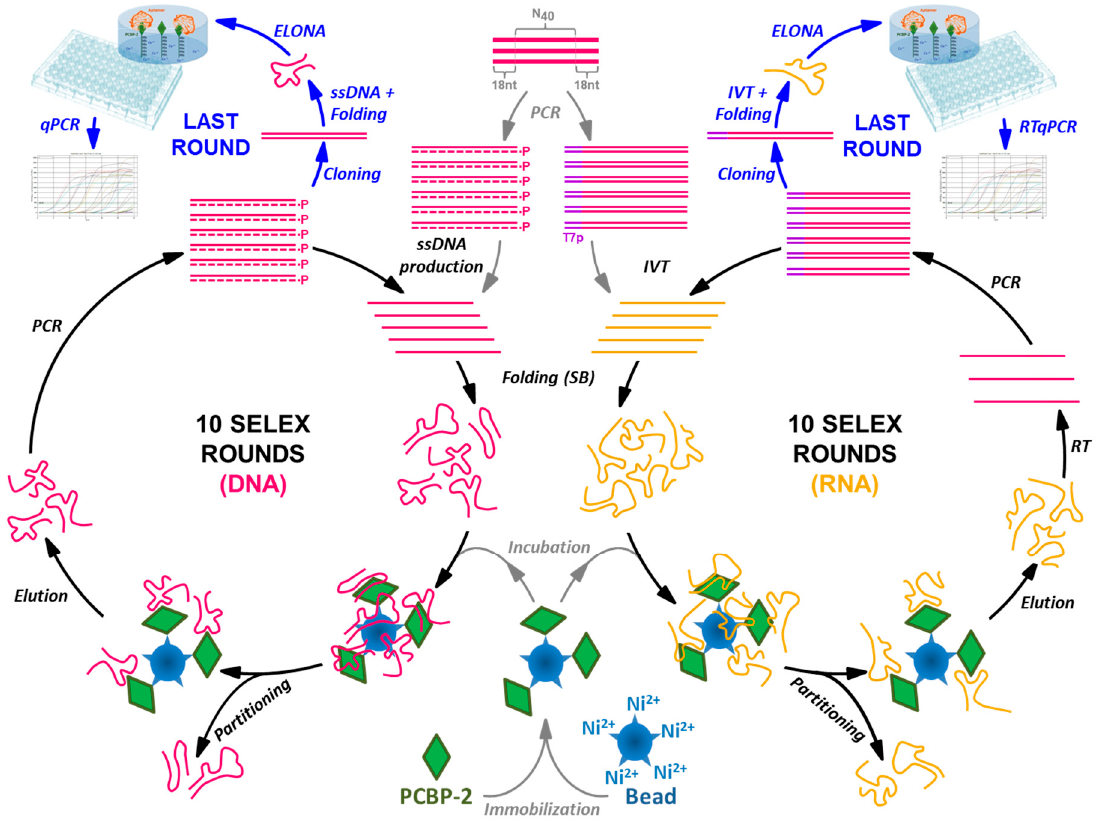
Figure 1. Schematic representation of the SELEX processes performed to select ssDNA and RNA aptamers in parallel using PCBP-2 as the target molecule, coupled to the ELONA-(RT)qPCR methodology developed for the functional characterization of the individual aptamers present at the last SELEX round.